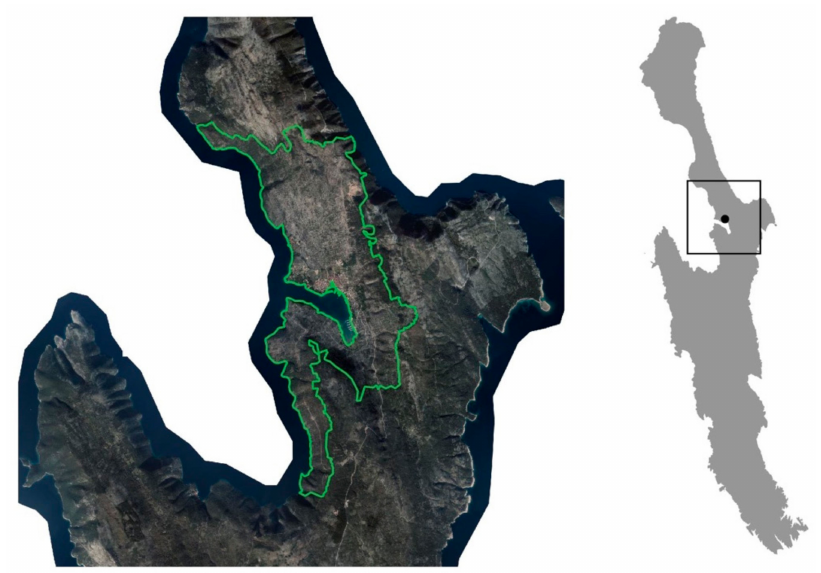
Figure 2. The research area and its location within the island of Cres. Basemap: digital orthophoto 2014/2016 (DOF 2014/16 WMS)